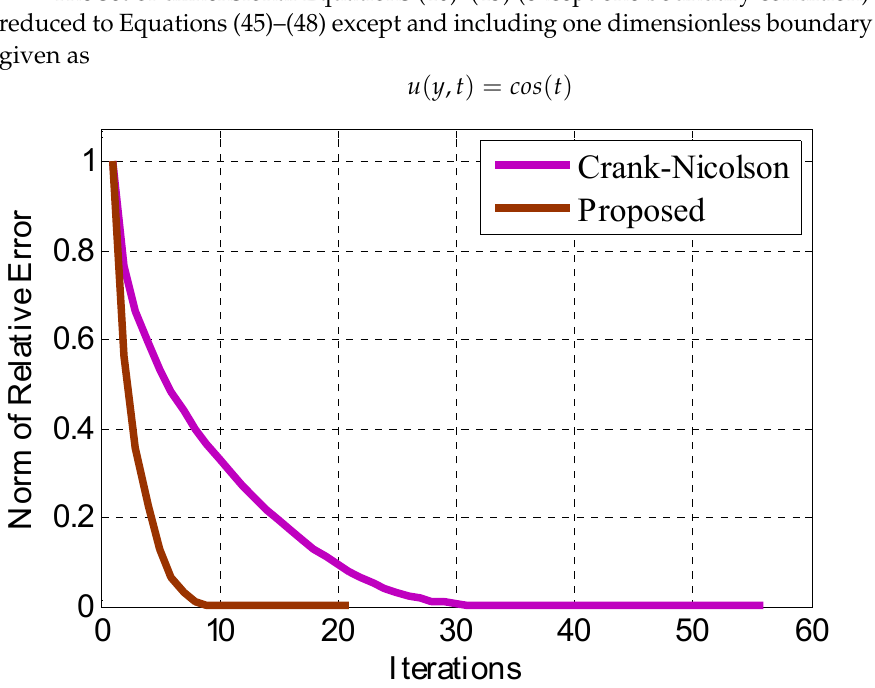
Figure 4. Comparison of speed of convergence of two schemes using M = 0, N = 0, N x = 40, N t = 200, L = 17, t f = 10.